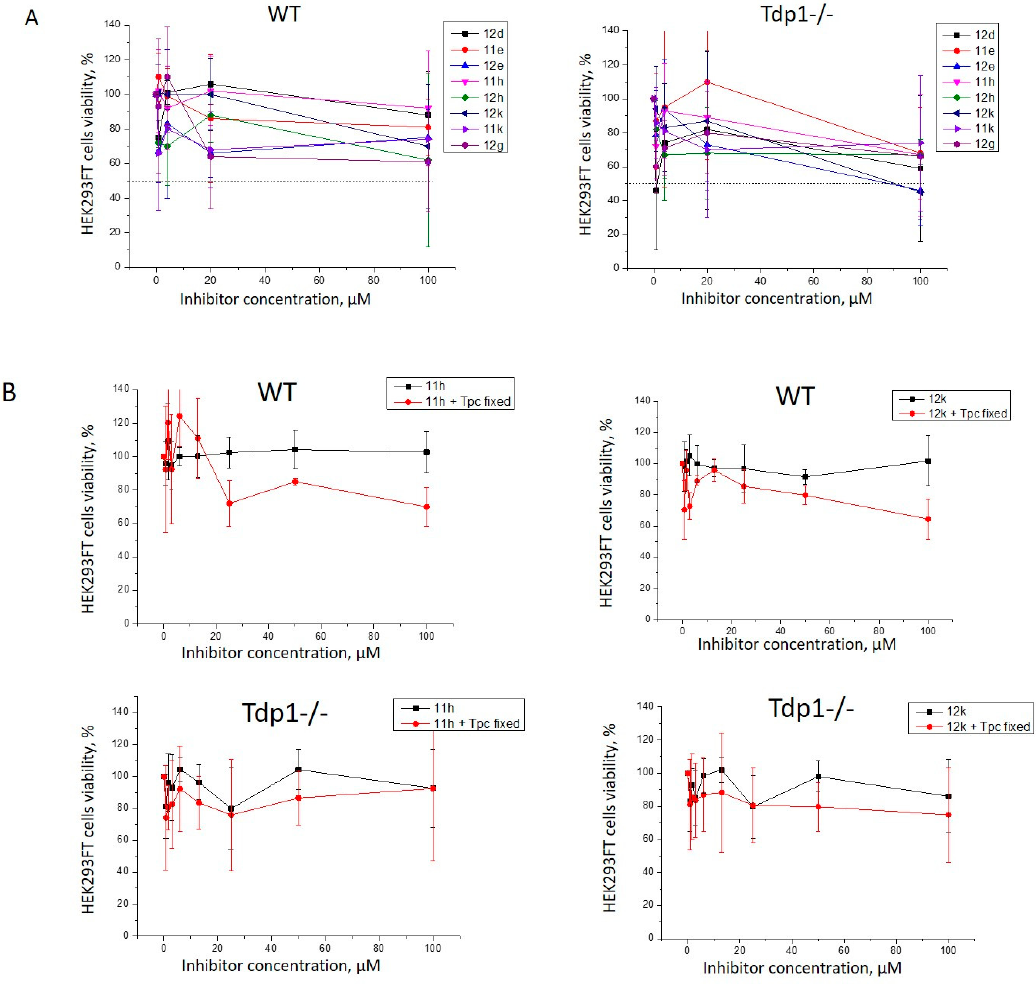
Figure 3. The TDP1 inhibitors’ intrinsic cytotoxicity on HEK293FT WT and TDP1 − / − cells ( A ). Dose-dependent action of the derivatives ( B ). Activity with topotecan (Tpc) against HEK293FT cells in combination with 11h and 12k . The Tpc concentration was 30 nM for TDP1 − / − and 200 nM for the WT cells.